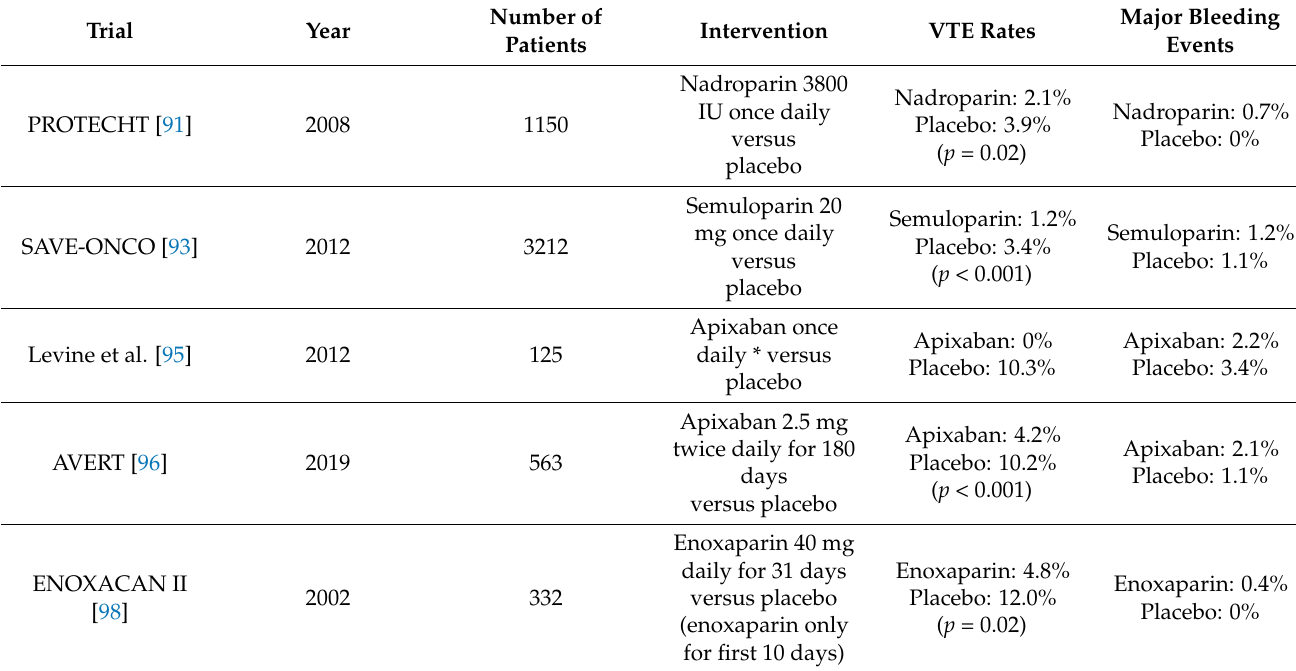
Table 3. Summary of studies in primary prophylaxis of cancer-associated